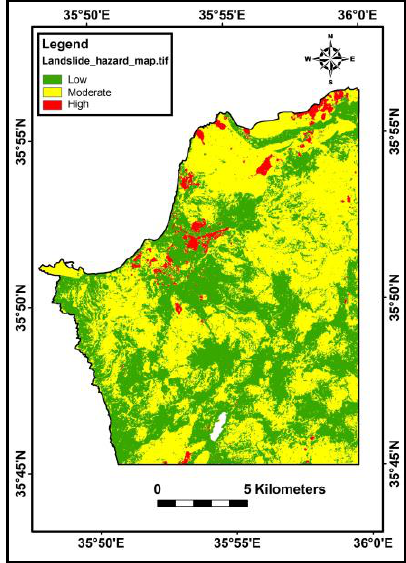
Figure 17. Landslide hazard map of the study area during the period from 16 October 2018 until 21 March